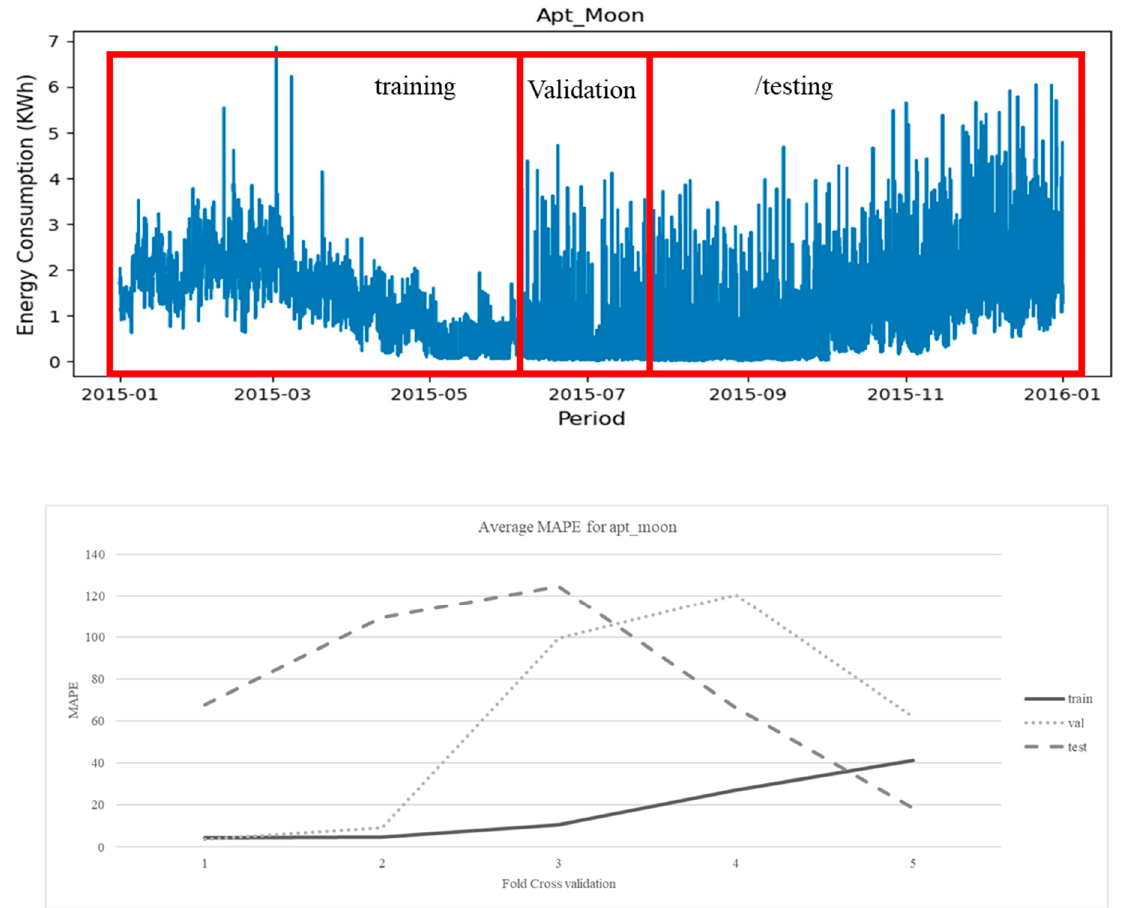
Figure 9. The pattern differences between training, validation, and testing set for Apt_moon dataset.